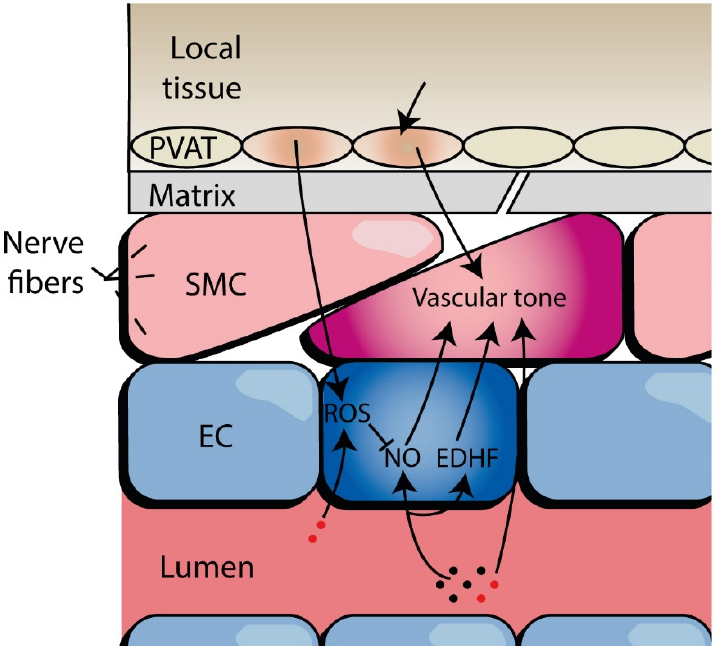
Figure 1. Example of intercellular signalling in an arteriole. A simplified example of the complex intercellular signalling of the microcirculation is displayed. This signalling is different per vessel type. It comprises a variety of systemic and local signals from surrounding tissue and the blood, acting in both the short- and long-term, including humoral, physical, neurogenic, cellular, and metabolic factors. Alterations in these signalling pathways and cellular abnormalities have been re- ported in HFpEF patients, including changes in matrix cell types and stiffness; adipose tissue cell phenotype and adipokine secretion; muscle cell hypertrophy and oxidative stress, and vasodilator response; endothelium-dependent vasodilation; microvascular rarefaction, and microvessel mor- phology. EC, endothelial cells; EDHF, endothelium-derived hyperpolarizing factors; NO, nitric ox- ide; PVAT, perivascular adipose tissue; ROS, reactive oxygen species; SMC, smooth muscle cells.